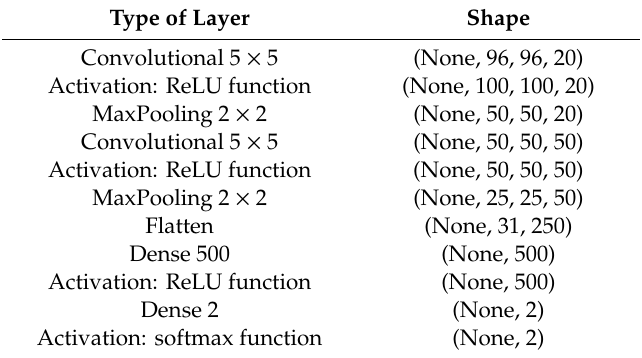
Table 1. Convolutional neural network (CNN) architecture. ReLU, rectified linear unit.